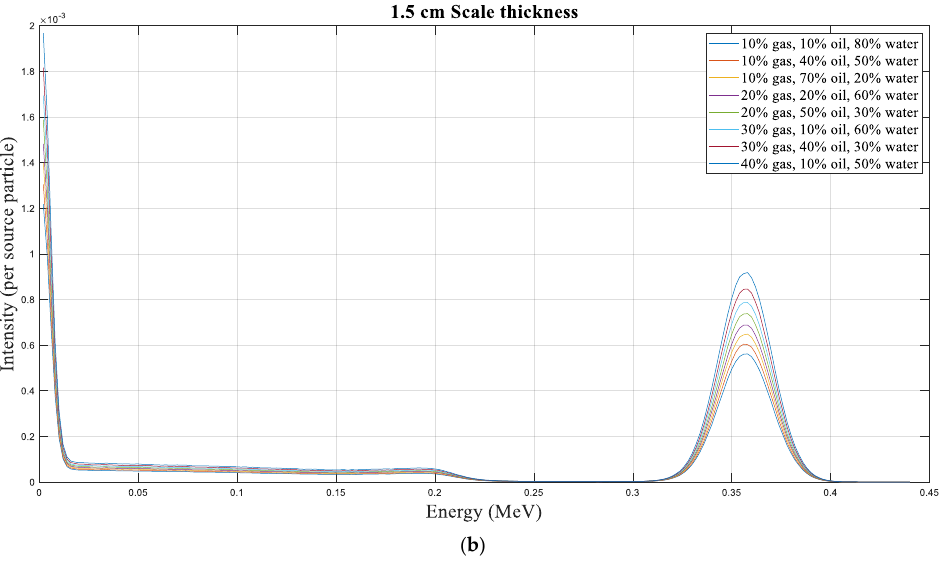
Figure 2. Spectrum received by sodium iodide detector for scale thickness of ( a ) 0 cm and ( b ) 1.5 cm. LamberteBeer’s law is used to determine the attenuation rate when a narrow gamma ray strikes an object.